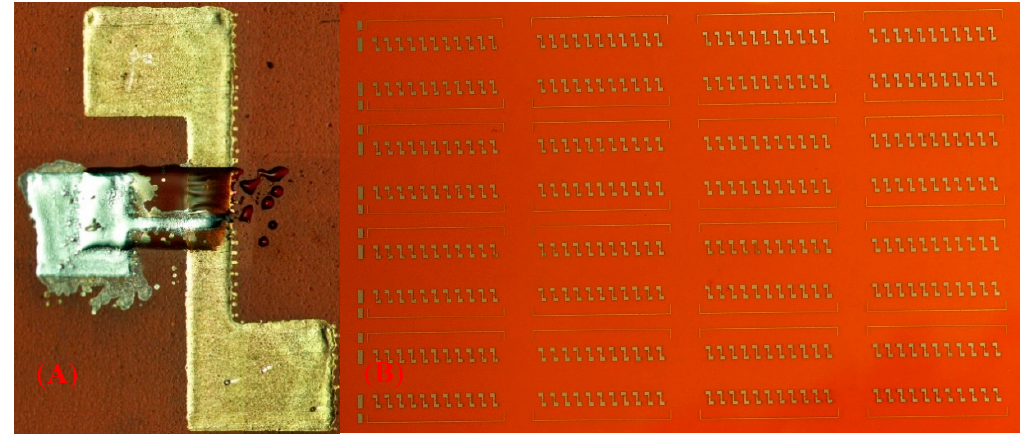
Figure 4. ( A ) A composite image of the final device produced. Multiple images were taken and assembled in order to create a higher resolution image. ( B ) An array of transistor devices in